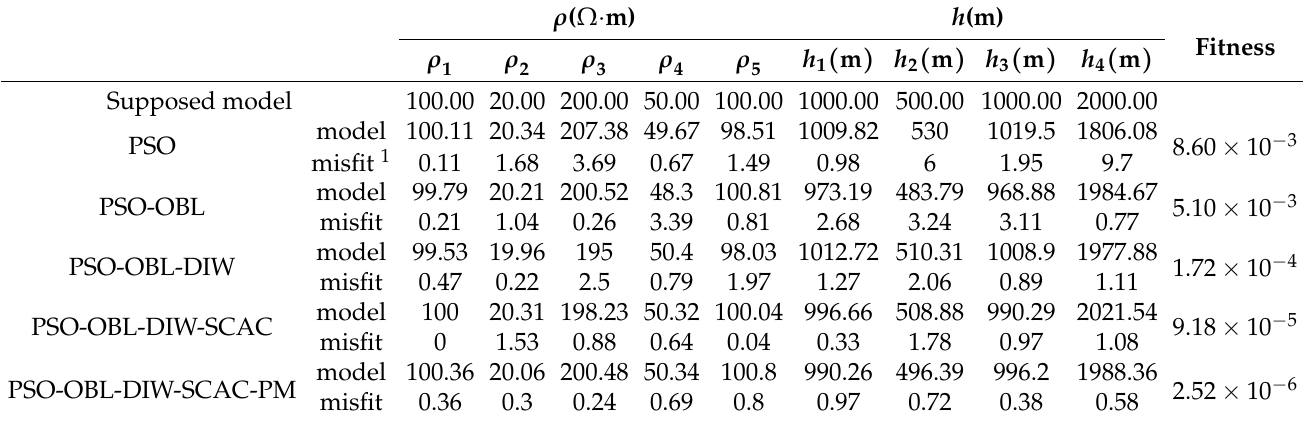
Table 2. Accuracy comparison of five-layer geoelectric model predicted by different